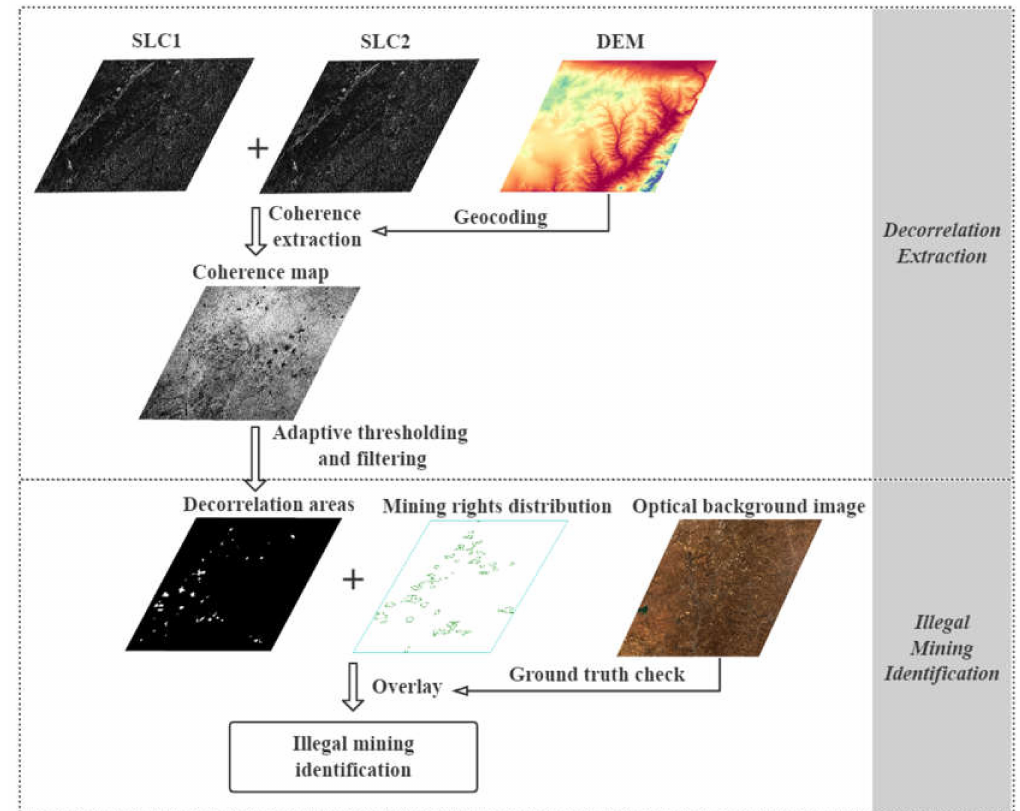
Figure 1. Workflow for interferometric synthetic aperture radar (InSAR) coherence identification of illegal open-pit mining